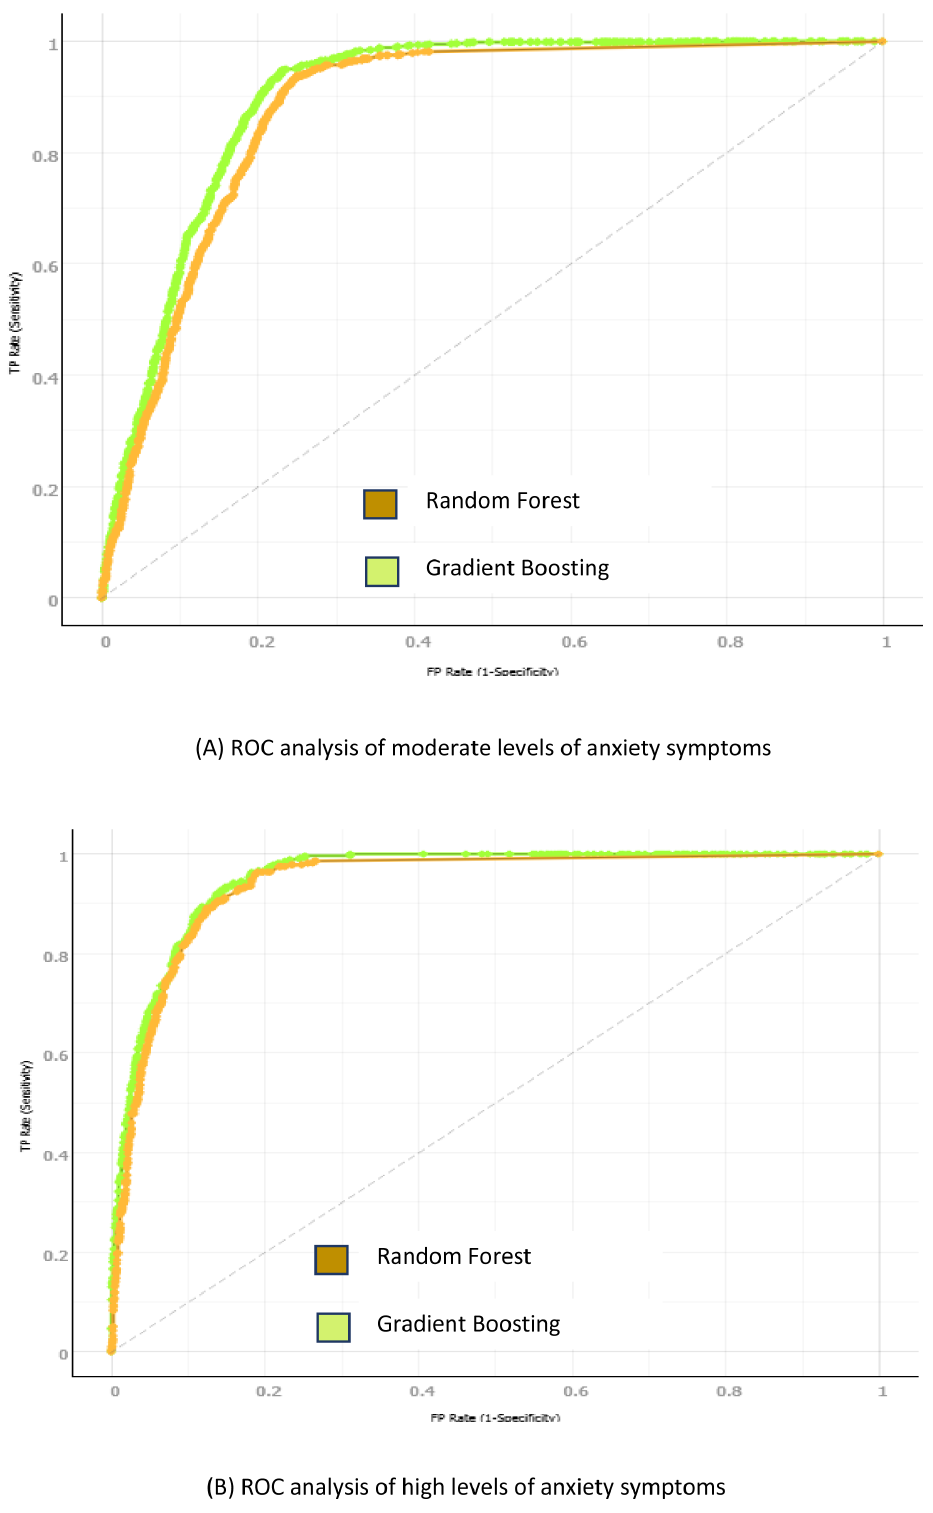
Figure 5. Gradient Boosting and Random Forest ROC sensitivity and specificity analysis: ( A ) Moderate anxiety symptoms analysis; ( B ) High anxiety symptoms